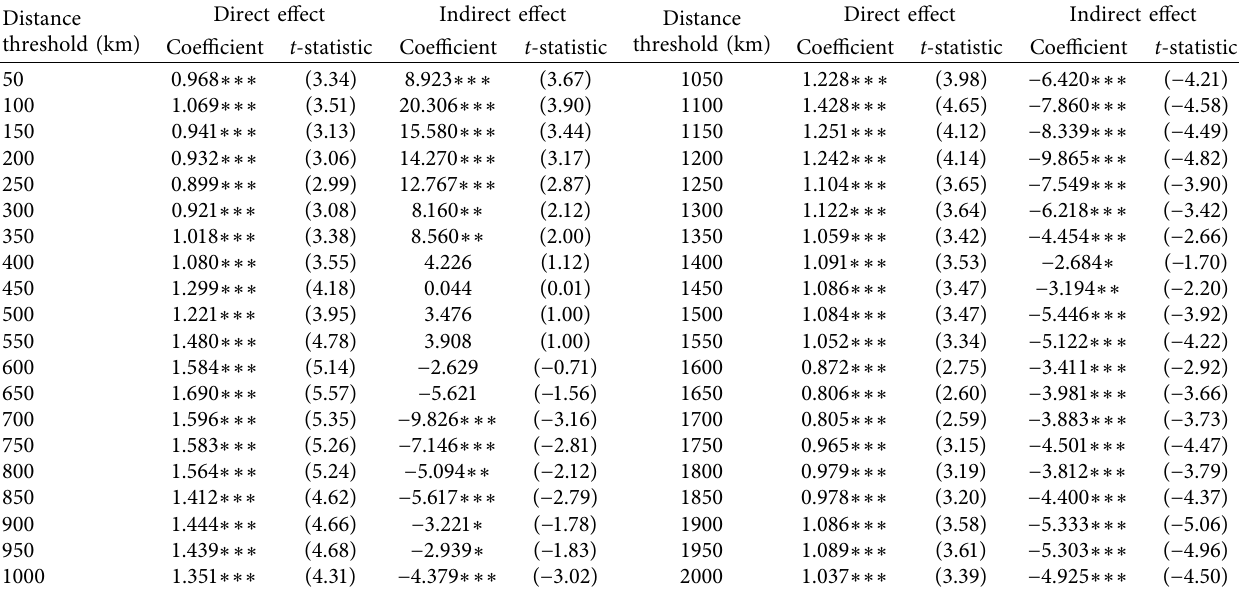
Table 13: Spatial spillover distance of the impact of the northern region’s digital economy on urban innovation.